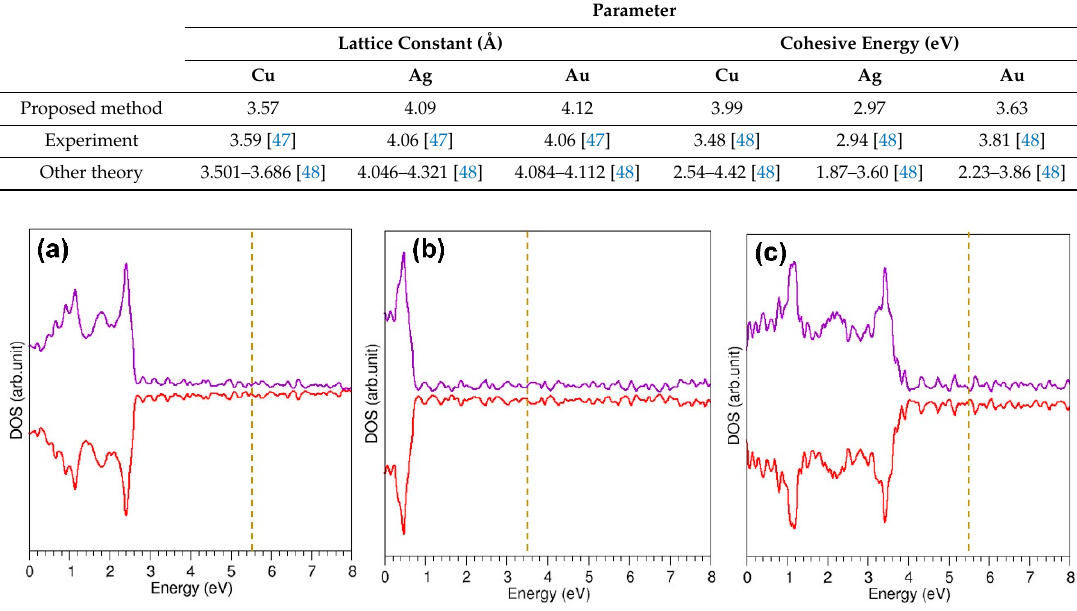
Table 1. Calculated and experimental lattice constants and cohesive energies of bulk coinage metals. Parameter Lattice constant (Å)